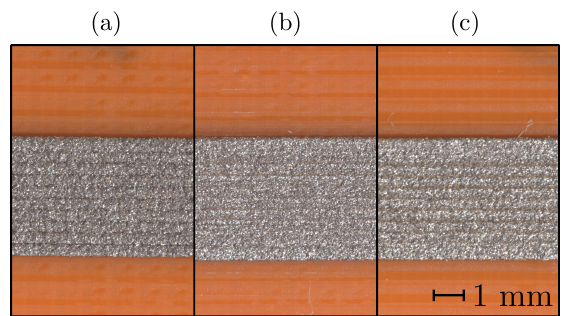
Figure 6. Bed temperature T bed influence: ( a ) T bed = 30 ◦ C, ( b ) T bed = 60 ◦ C, ( c ) T bed = 90 ◦ C.